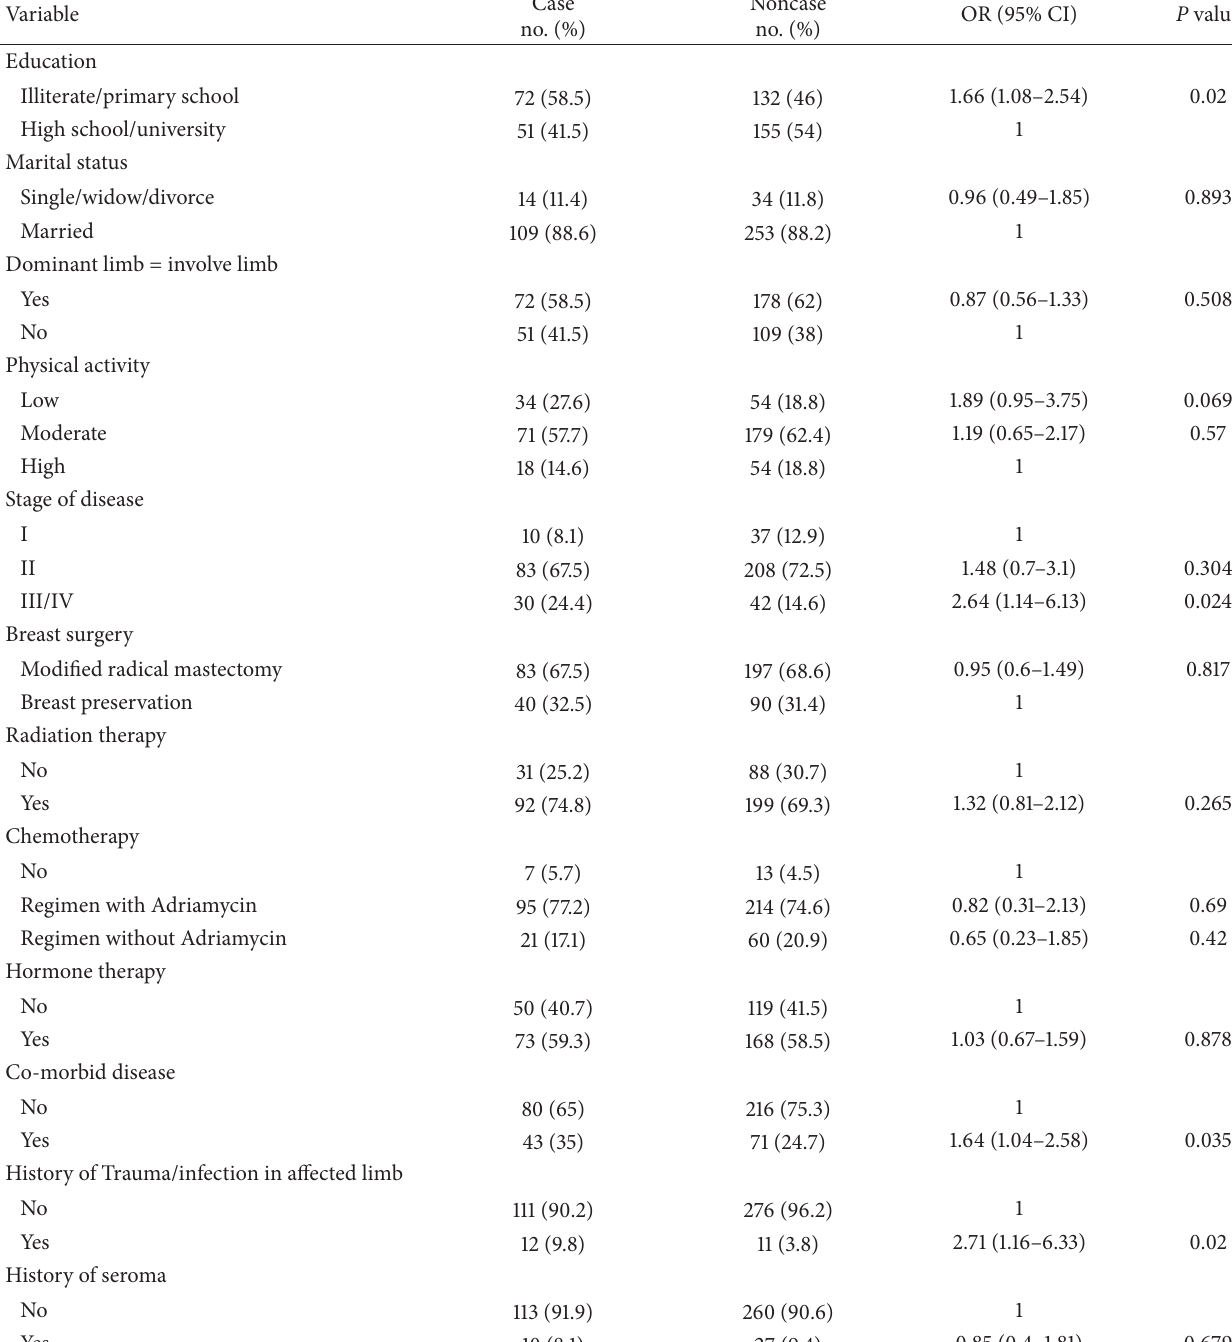
Table 1: Demographic and clinical characteristic of